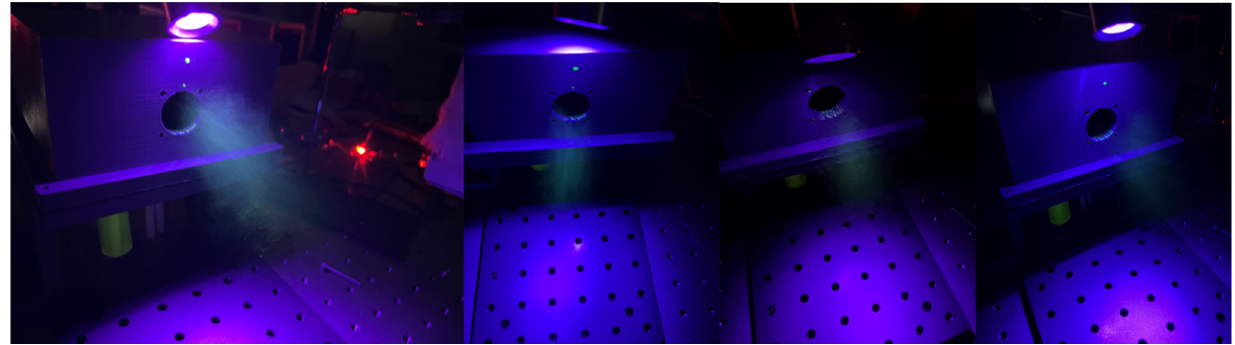
Figure 10. Practical results of the odor generation with different flow rates.